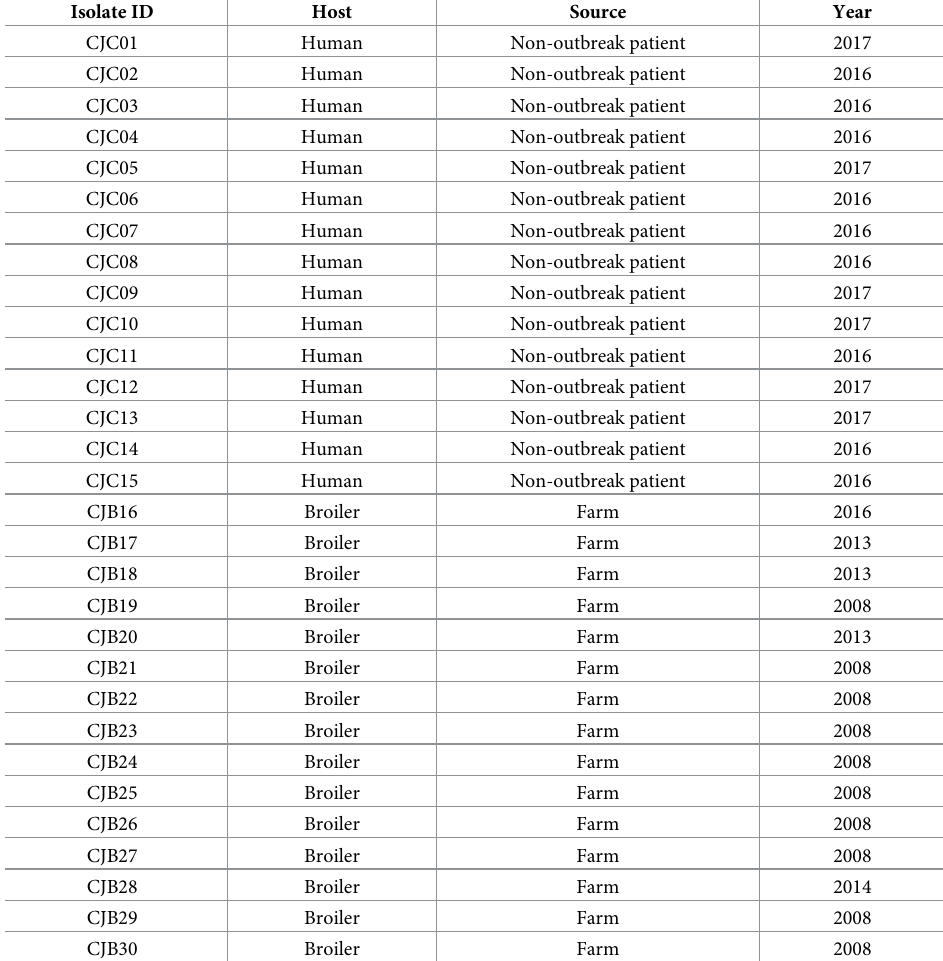
Table 1. Sources of the clinical and broiler C . jejuni isolates selected for this study. Isolate